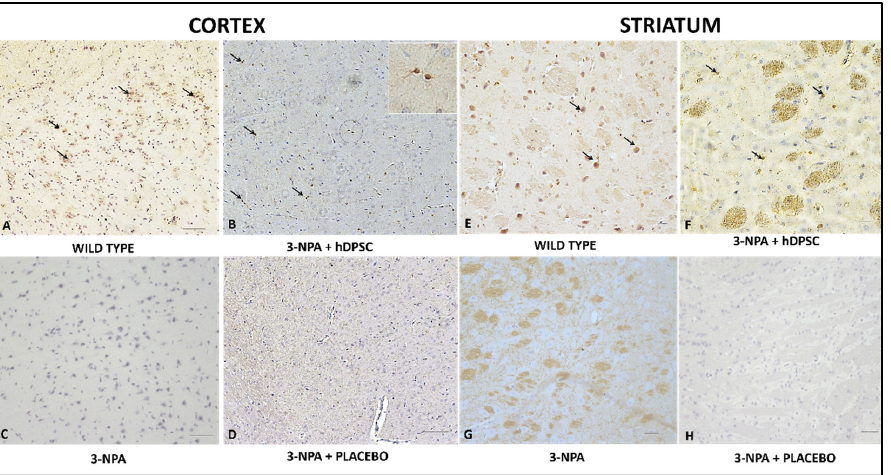
Figure 7. Analysis of anti-D2R antibody expression in the cortex ( A – D ) and striatum ( E – H ) in four studied groups: wild type ( A , E ); 3NPA+ hIDPSC ( B , F ); 3NPA ( C , G ) and 3NPA + Placebo ( D , H ), respectively. Results show positive immunostaining for anti-D2R antibody in the cortex ( A ) and striatum ( E ) of wild-type rats, positive control, as well as in the cortex ( B ) and striatum ( F ) of 3NPA + hIDPSCs. The loss of D2R expression is observed in the cortex ( C , D ) and striatum ( G , H ) of rats treated with 3NPA, as well as in rats 3NPA + Placebo, respectively. Black arrows indicate anti-D2R expressing cells. Sections are contra stained with HE. Scale bars: ( A – D , C , H ) = 50 μ m; ( E , F ) and Inset in ( B ) = 10. Analysis performed 30 days (D35) after the treatments. 3.5. Quantitative Immunohistochemical Staining Assessment for BDNF, DARPP32 and D2R Statistical analysis, based on the number of immunolabelled cells, proved that the treatment with hIDPSCs restored the expression of BNDF, DARPP32 and D2R in the cor- tex and striatum of 3-NP rats (Figure 8). In the cortex, we observed that the hIDPSCs in- creased the number of BDNF-positive cells (G1–G4), when compared to the group of ani- mals treated with placebo (CG1) (Figure 8). However, there is no verified statistical differ- ences between the low (1 × 10 6 cells) and high cell dose (1 × 10 7 cells, Figure 7). By contrast, we observed an increase of D2R-positive cells within the cortex of 3-NP rats treated with the high cell dose (Figure 8). These results were observed in 3-NP rats treated with both single or triple doses of hIDPC (Figure 8), demonstrating that only one single hIDPSC intravenous administration can restore the expression of these biomarkers in the rat brain. By contrast, for the striatum (the main affected brain area by HD), only the low cell dose increased the number of BDNF, DARPP32 and D2R-positive cells (Figure 8). However, there was not observed statistical differences between the single or triple doses (>0.05), reinforcing that only one single hIDPSC intravenous administration can restore the ex- pression of these biomarkers in the rat brain.